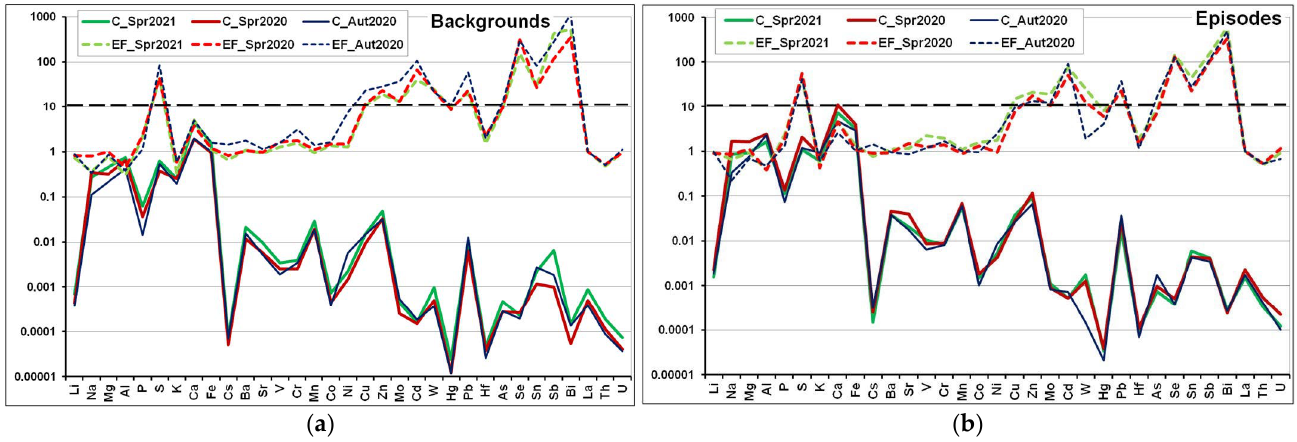
Figure 11. Comparison of elemental composition of near-surface aerosol for three episodes of high aerosol air pollution in Moscow (spring 2021, spring 2020 and autumn 2020) associated with atmospheric transport of pollutants from other areas: ( a , b )–concentration C ( µ g/m 3 ) and enrichment factor EF (formula 1) of elements under background and episode conditions, respectively. Black dashed lines are the level of EF = 10.